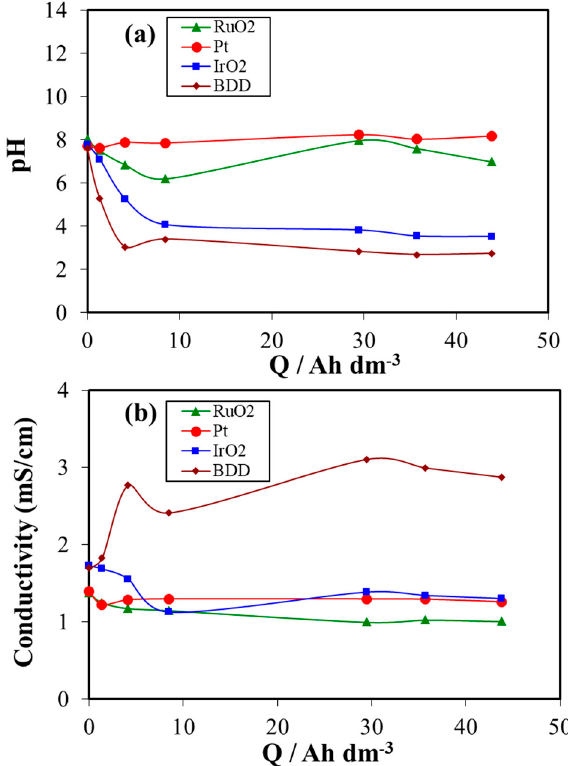
Figure 3. Changes in the ( a ) pH and ( b ) conductivity of the electrolyte with the applied electric charge during the electrochemical treatment of urine wastewaters at four di ff erent anode materials.